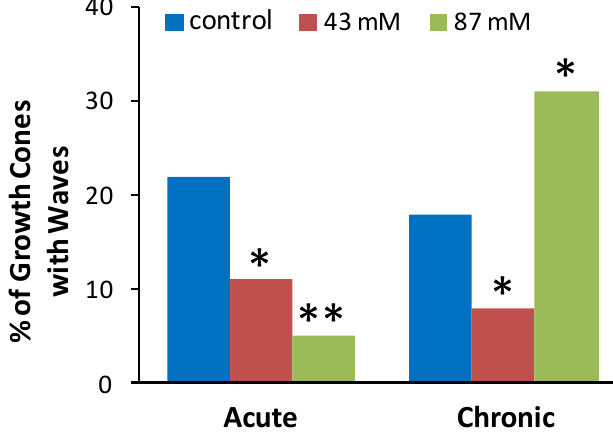
Figure 3. Ethanol alters the incidence of spontaneous calcium waves in axonal growth cones. The plot shows the percent of neurons in each treatment group that exhibited at least one Ca 2+ wave during the 10 min. recording. The data are combined from 39 separate cultures with a total of 453 growth cones analyzed (54–91 per treatment group). * p < 0.05, ** p < 0.001, chi square, compared to control group for acute or chronic